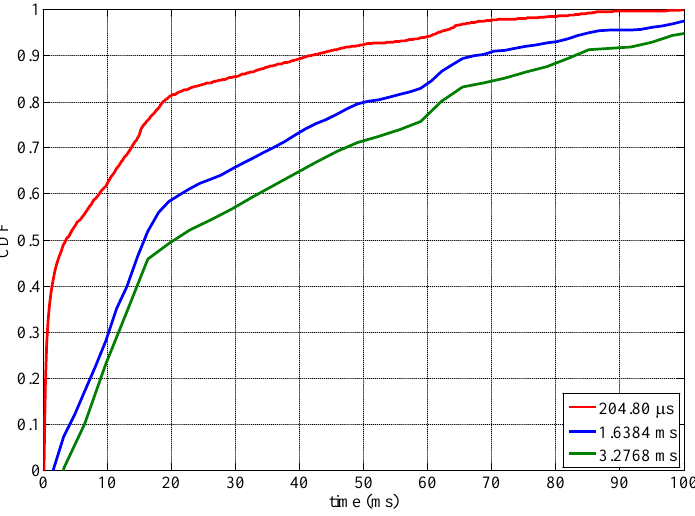
Figure 9. Effect of time resolution on empirical CDF of channel ‘12’.